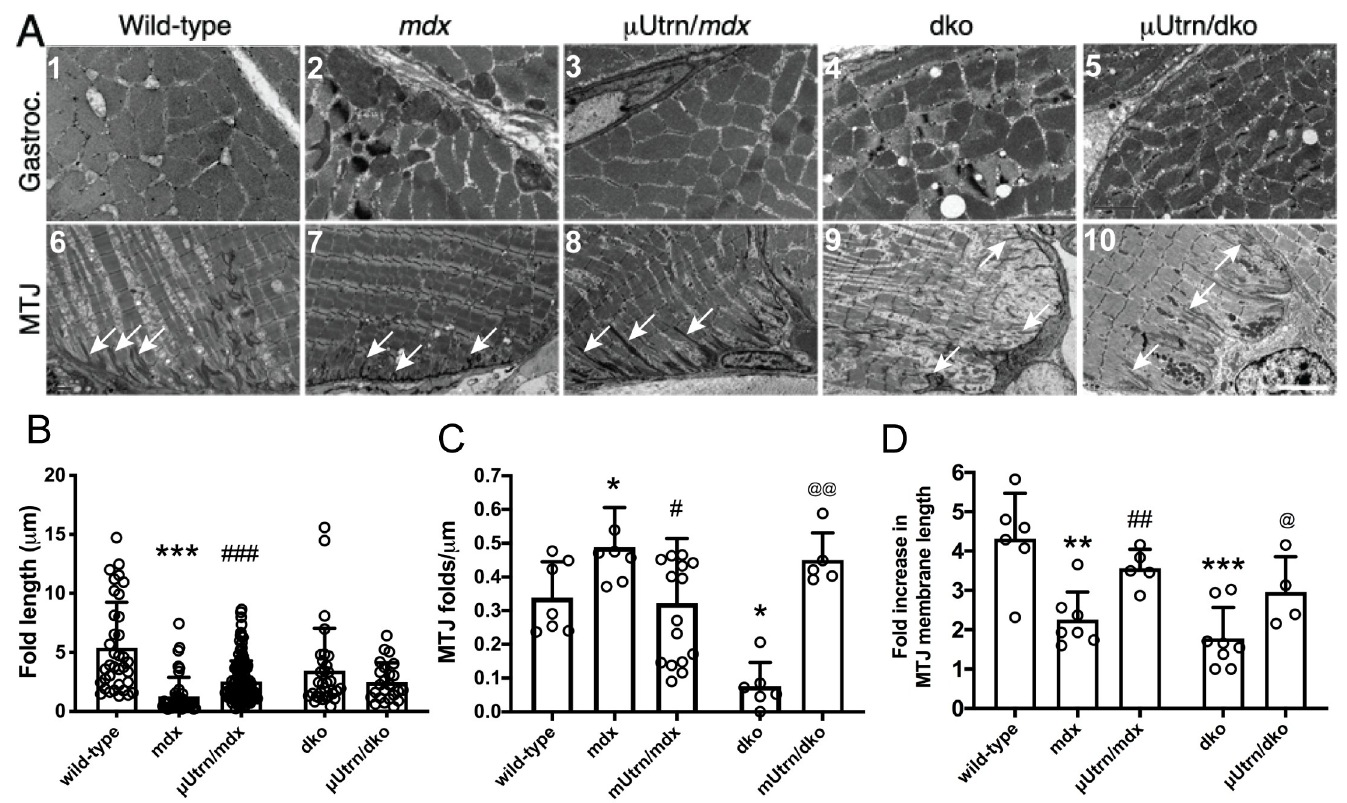
Fig 7. μ Utrn expression partially restores the structure of myotendinous junctions without leading to ringed fiber formation. (A) Top panel: Electron microscopy of transverse sections of gastrocnemius muscles. Scale bar = 2 μ m. Lower panel: Longitudinal sections of Achilles myotendinous junctions. Note the loss of folds in mdx 4cv and dko mice is partially restored by μ Utrn expression. Scale bar = 5 μ m. (B) Mean +/- S.D. length of folds. (C) Mean +/- S.D. fold per μ m of MTJ. (D) Mean +/- S.D. increase in membrane length brought about by the MTJ